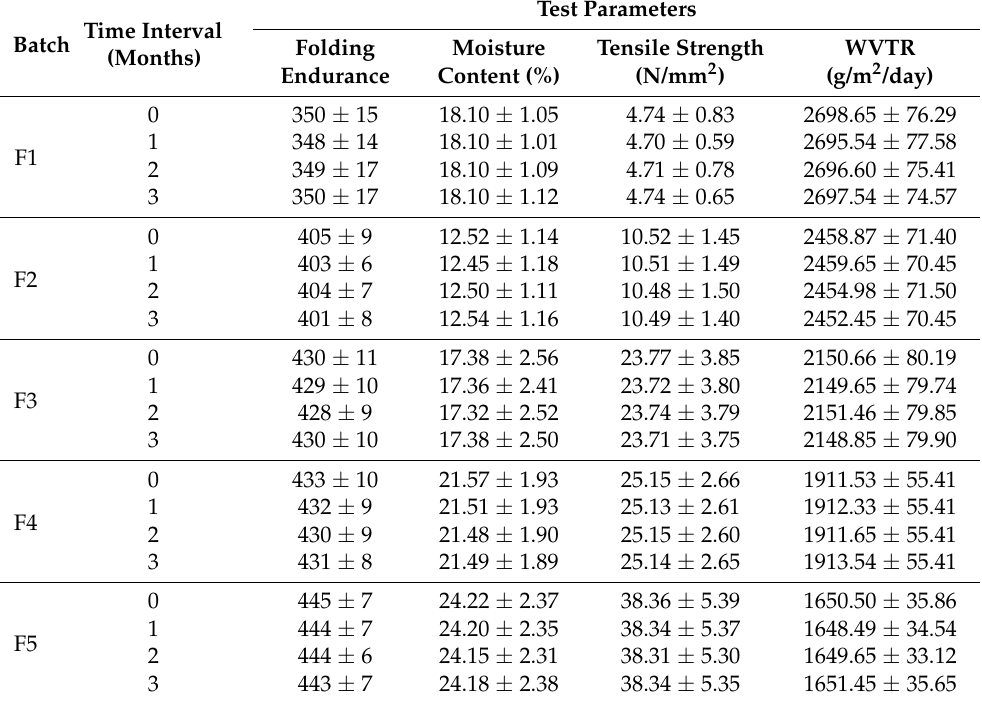
Table 4. Stability testing data for the prepared hydrogel